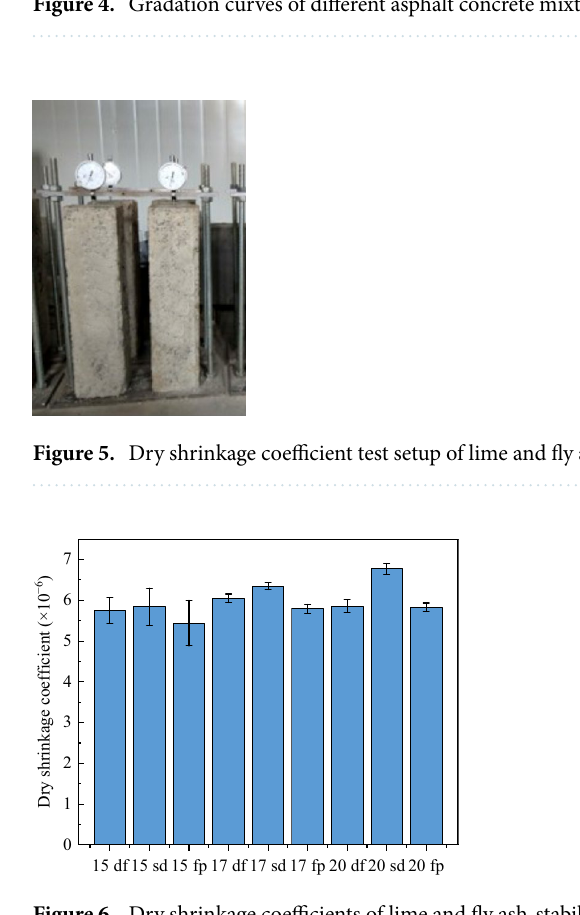
Figure 4. Gradation curves of different asphalt concrete mixtures.